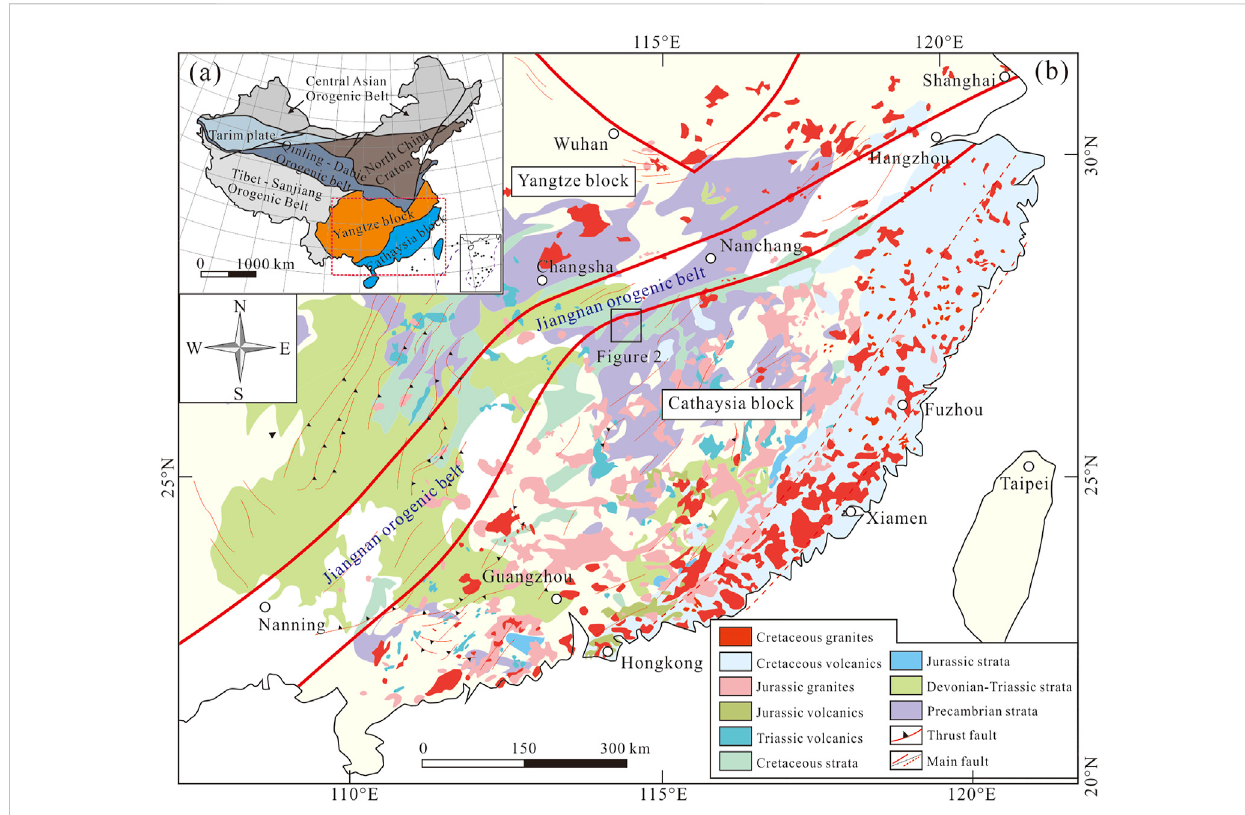
FIGURE 1 (A) Structure outline map of China (modi fi ed from Zhao and Guo, 2012); (B) regional geological map of South China (modi fi ed from He et al.,